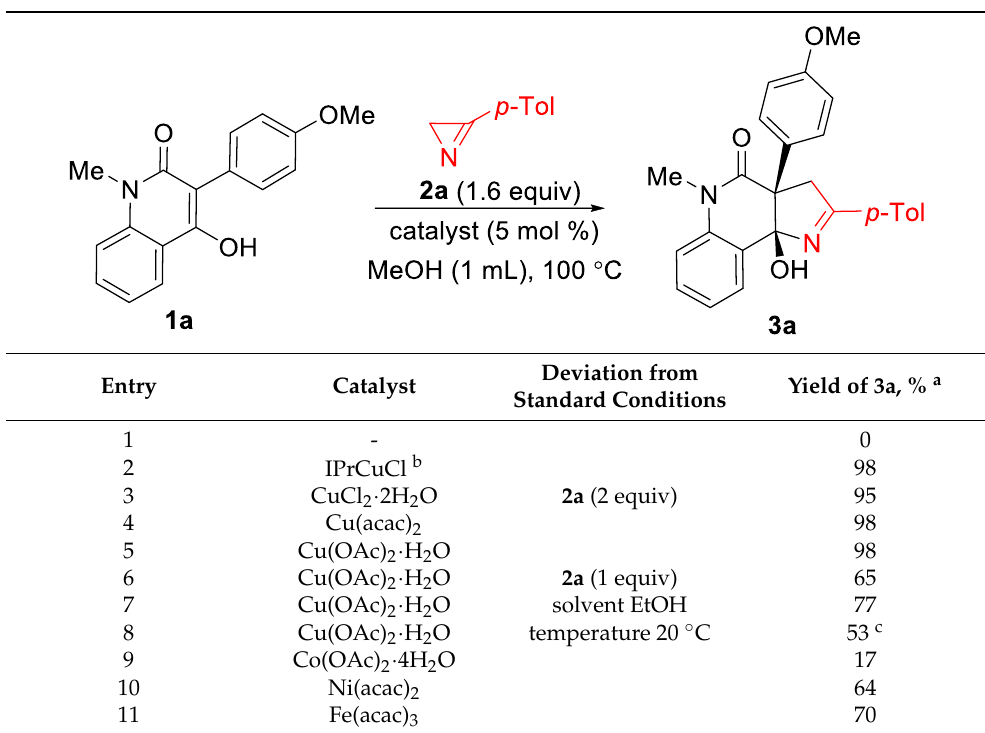
Table 1. Optimization of synthesis of 3a.